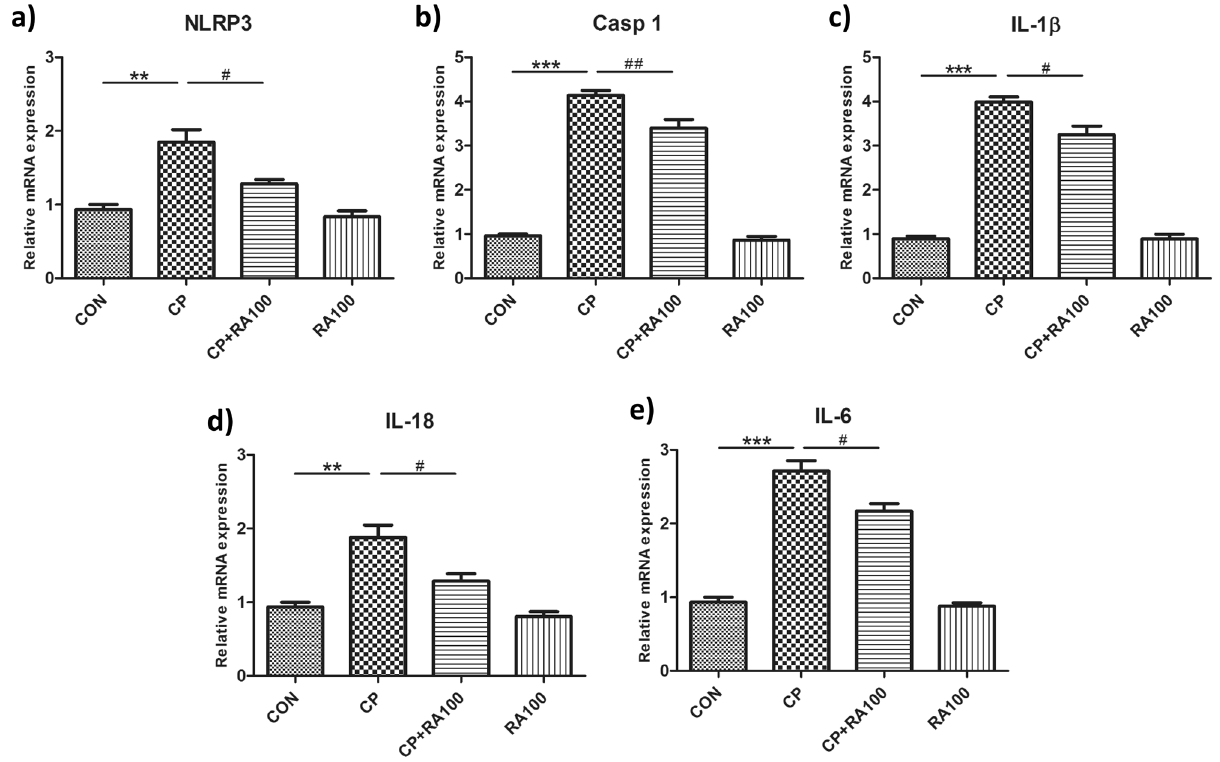
Figure 3. mRNA expression analysis of NLRP3, caspase-1, IL-1β, IL-18 and IL-6 in the kidney tissue after the administration of CP and RA. The treatment of CP at the dose of 20 mg/kg caused a significant upregulation in the expression of NLRP3 (** p < 0.01) ( a ), caspase-1 (*** p < 0.001) ( b ), IL-1β (*** p < 0.001) ( c ), IL-18 (** p < 0.01) ( d ) and IL-6 (*** p < 0.001) ( e ) at mRNA levels when compared with control group of animals. On the other hand, the administration of RA at the dose of 100 mg/kg caused a significant down-regulation in the expression of NLRP3 ( # p < 0.05), caspase-1 ( ## p < 0.01), IL-1β ( # p < 0.05), IL-18 ( # p < 0.05) and IL- 6 ( # p < 0.05) at mRNA level when compared with CP-treated group of animals. There was no significant difference in RA only treated animals when compared with control group of animals. Each value is represented as mean ± SEM ( n = pared with control mice. However, the m-RNA expression of IL-18 and IL-6 genes was found to be reduced with 1.2 and 2.1 folds, respectively in CP + RA100 treated mice in comparison to CP-treated animals. The m-RNA expression results revealed that expression of proinflammatory genes in CP-treated mice was down-regulated in CP + RA100-treated mice in a significant manner ( p < 0.05 in case of NLRP3 , IL-1β , IL-18 and IL-6 and p < 0.01 in case of caspase-1 ).